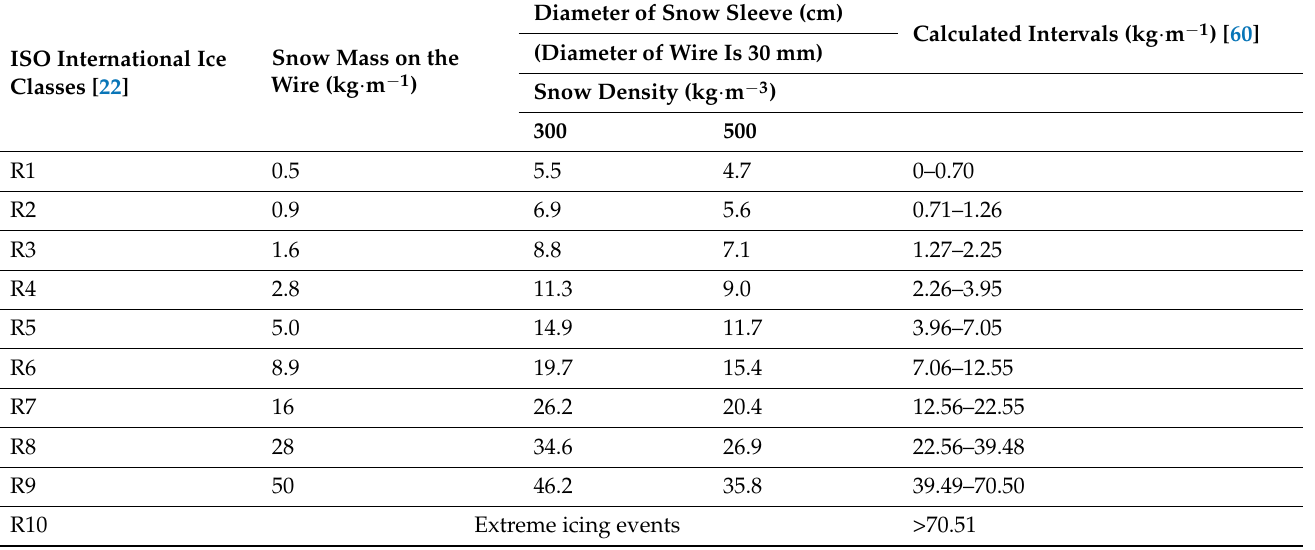
Table 4. International Ice Classes, and related mass (kg · m − 1 ) and diameter (cm) of accumu- lated wet snow on transmission overhead lines determined for two snow densities (300 kg m − 3 , 500 kg m − 3 ) based on [22]. Calculated intervals are determined by Ducloux and Nygaard based on the 79% and 141% value of the diameter of snow sleeve (cm) as the lower and upper limits of the calculated intervals